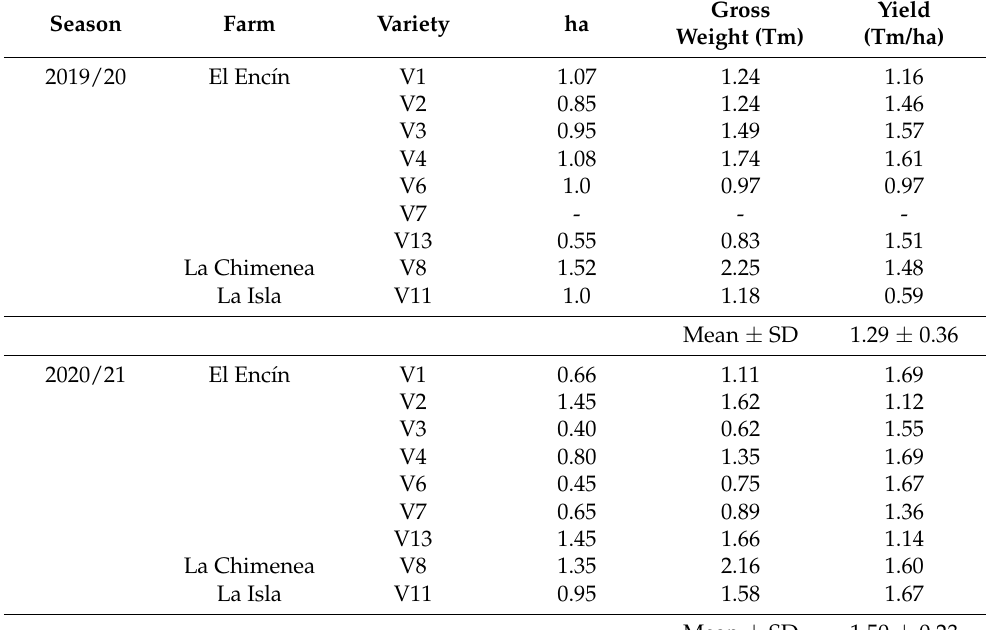
Table 1. Yields of Camelina sativa varieties (season 2019/2020). Season